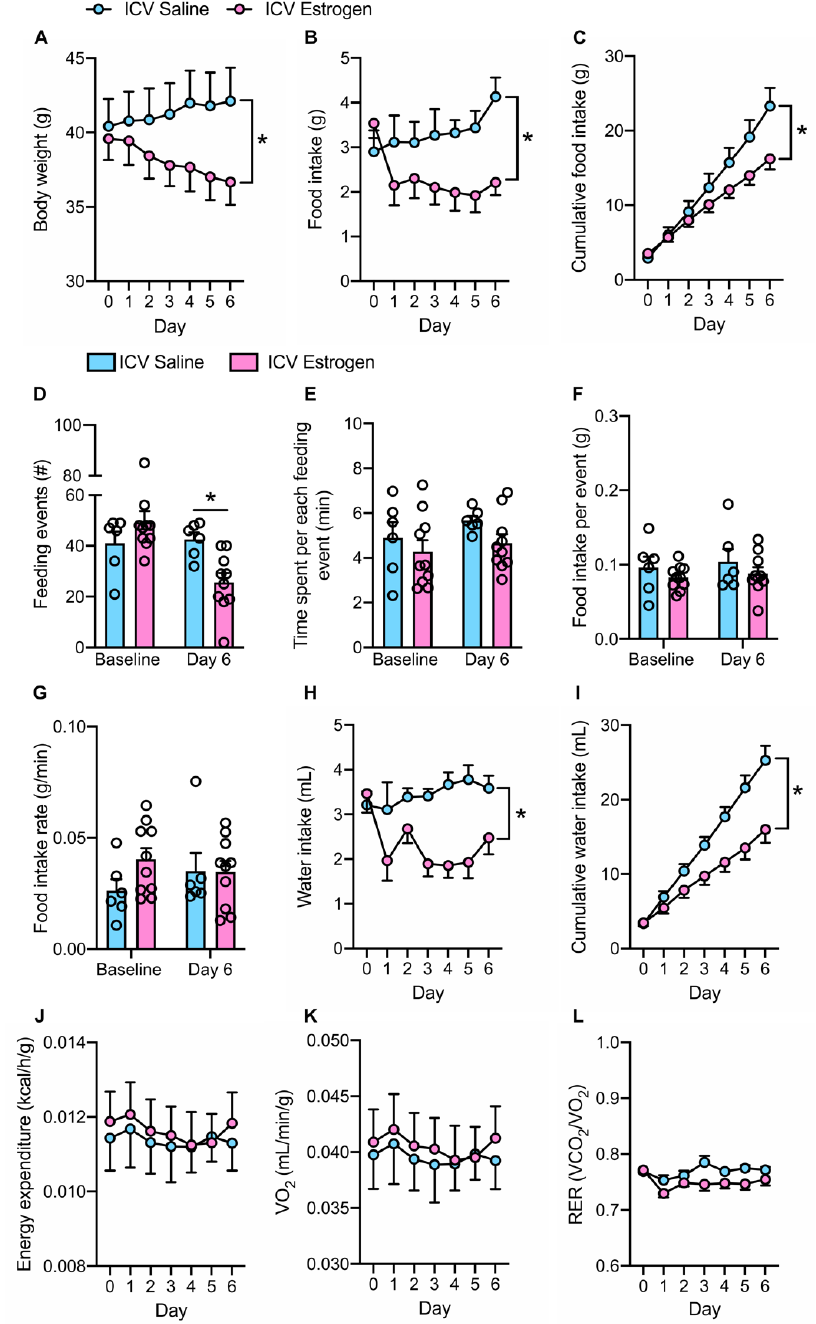
Figure 2. Central estrogen supplementation decreases body weight, food intake and water intake in obese males. ( A ) Body weight, ( B ) daily food intake, and ( C ) cumulative food intake at baseline and during 6-day administration of ICV 17- β -estradiol or saline control in obese male mice. ( D ) Feeding events, ( E ) time spent per each feeding event, ( F ) food consumed per feeding event, and ( G ) food intake rate at baseline and following 6-day administration of ICV 17- β -estradiol or saline control. ( H ) Daily water intake, ( I ) cumulative water intake, ( J ) energy expenditure, ( K ) oxygen consumption, and ( L ) respiratory exchange ratio at baseline and during 6-day administration of ICV 17- β -estradiol or saline control in obese male mice. n = 8 – 11. * p < 0.05 vs. ICV Saline.